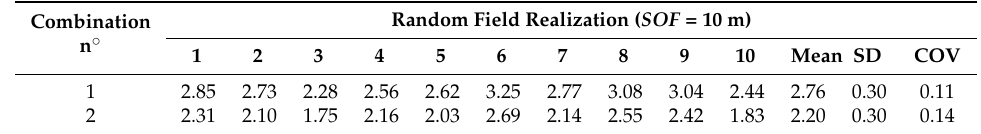
Table 18. Factors of safety results for spatially varied strength parameters with scale of fluctuation of 10 m.